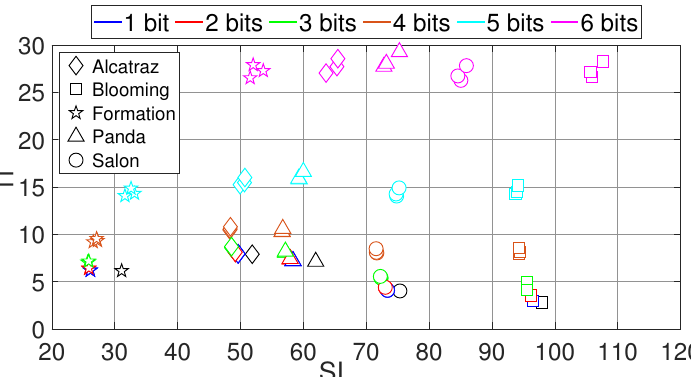
Figure 7. TI versus SI for 360 ◦ stego-videos with data hiding in the entire frames with b = 1, . . . ,6 (black markers relate to the 360 ◦ cover